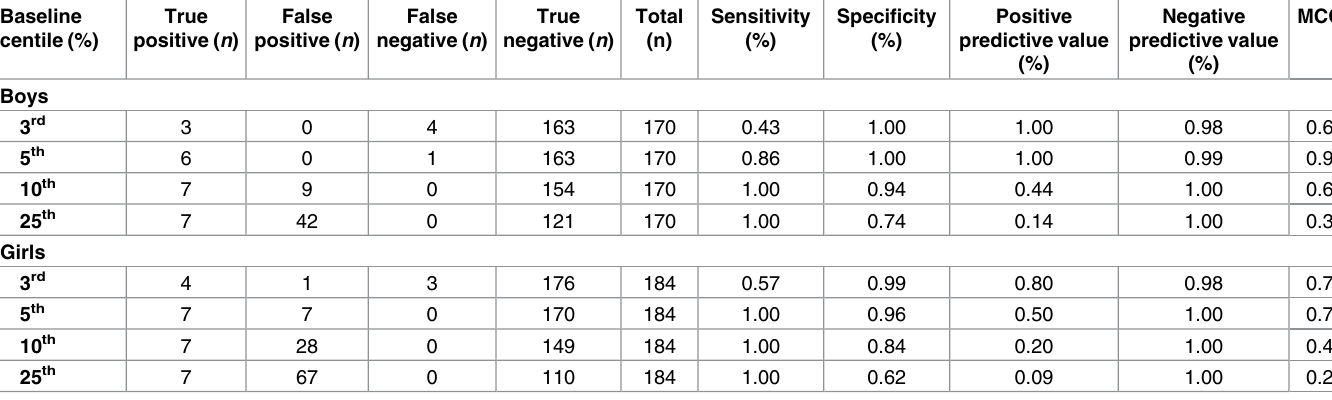
Table 3. The accuracyof baseline centiles to identify first-born twins with high myopia (SE (cid:20) -6.0D) at the age of 15 yearsby sex. Baseline True centile (%) positive ( n